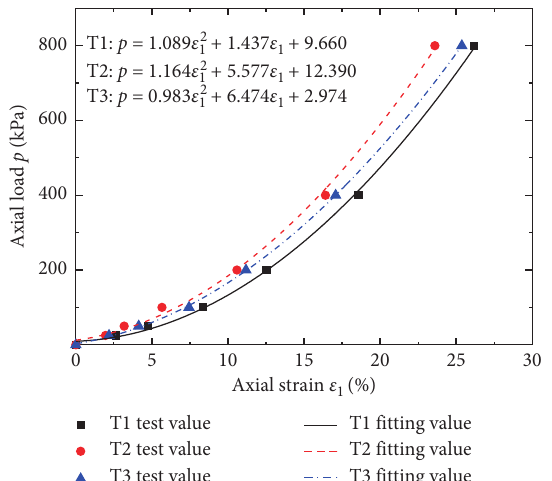
Figure 4: Axial strain and axial load curves of one-dimensional consolidation tests ( ε 1 ∼ p ).